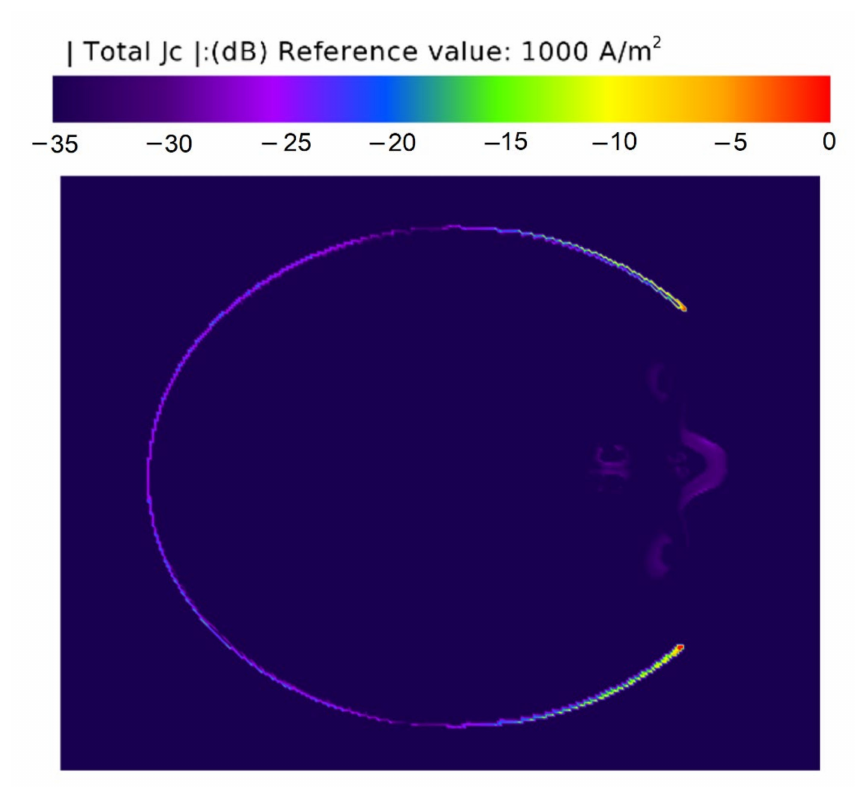
Figure 17. Current distribution for 750